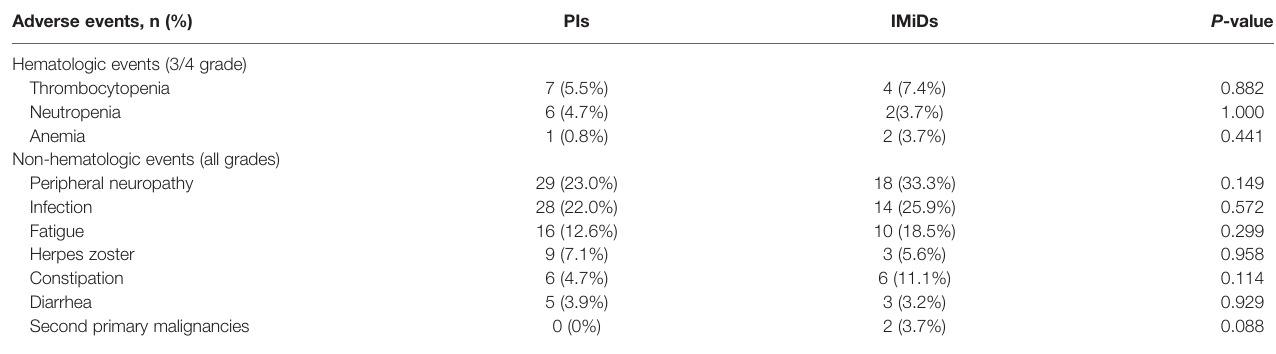
TABLE 4 | Analysis of adverse reactions produced by PIs and IMiDs maintenance therapy. Adverse events, n (%) PIs IMiDs P -value Hematologic events (3/4 grade)